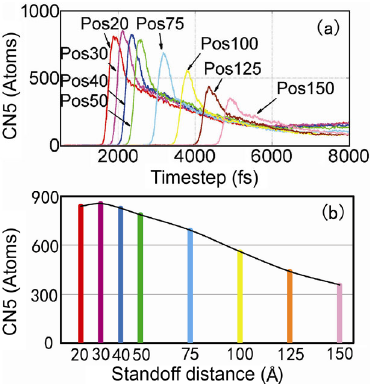
Fig. 4 (a) The CN5 variation curve with time during jet impinge- ment on substrate with different standoff distances. In order to make figures clear, the data after 8,000 fs was not shown; (b) the CN5max variation curve with different standoff distances.